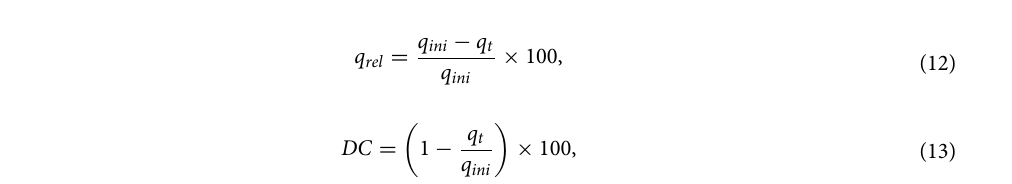
Figure 3. Sampled DS and ABF points along the MTI lateral for each respective